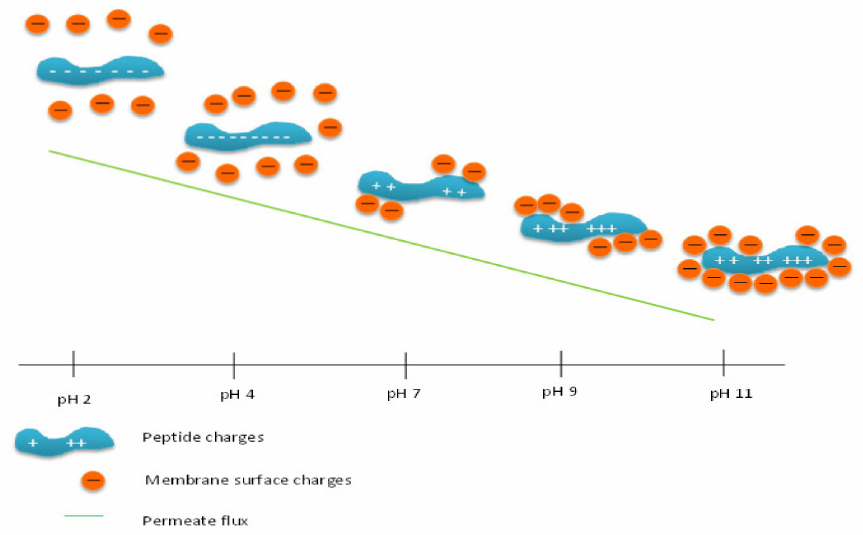
Figure 9. Schematic drawing of peptide structure and membrane surface state for the two-stage membrane.